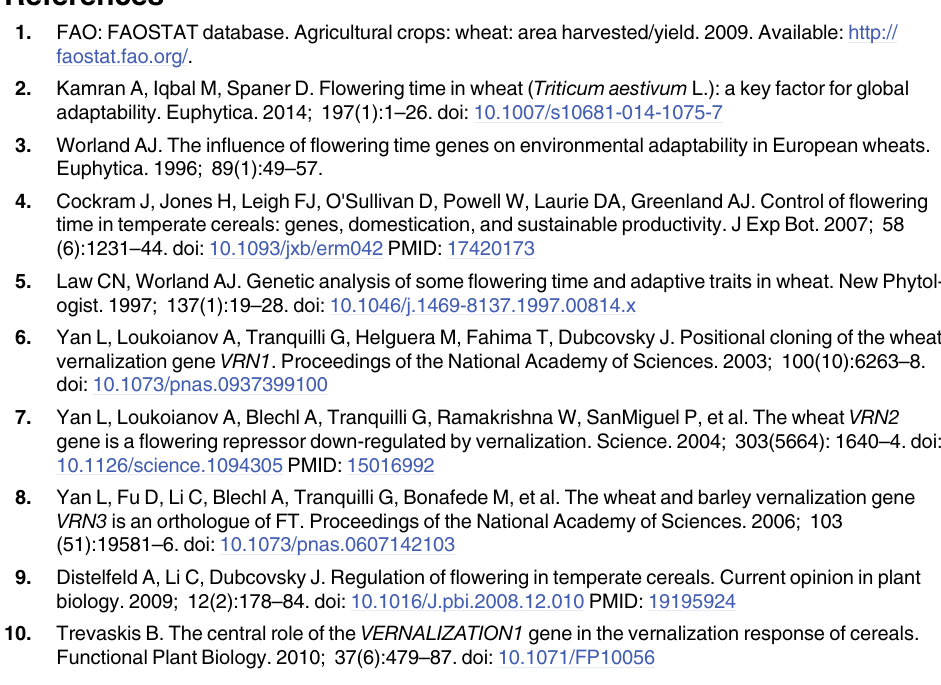
S4 Table. Distribution of markers on linkage map of the AGS 2000 by 26R61 RIL mapping population. S5 Table. Map location and genotypic data for parents and RILs for unique loci in the AGS 2000 by 26R61 mapping population. S6 Table. Heading date of AGS 2000, 26R61 and the RILs in the greenhouse and field. Days to heading were evaluated in the greenhouse following 8 weeks (8W), 4 weeks (4W) and 2 weeks (2W) of vernalization treatment. Heading date was recorded as day of year when lines were grown in the field in Baton Rouge, LA, Plains, GA and Raleigh, NC during 2012, 2013 and